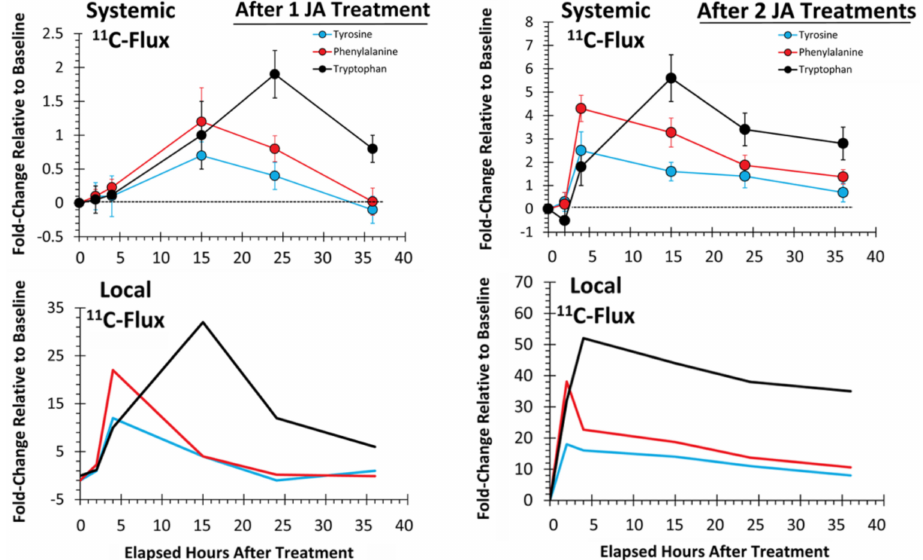
Figure 7. Systemic tissue responses to 500 µ M JA treatments—partitioning of ‘new’ carbon (as 11 C) into tyrosine, phenylalanine and tryptophan aromatic AAs is presented after sequential JA treatments (top panels). Data (N = 3) reflect the fold-change relative to baseline ± SE at timepoints 2, 4, 15, 24 and 36 h post-treatment. The 11 C temporal profiles for local tissue responses from Figure 4 are shown in the lower panels for a